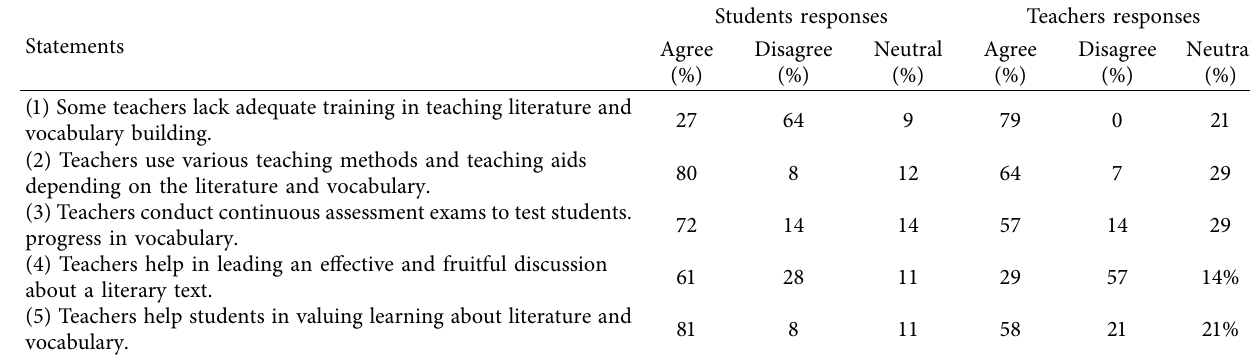
Table 1: Summary of subjects’ responses to teacher factor.